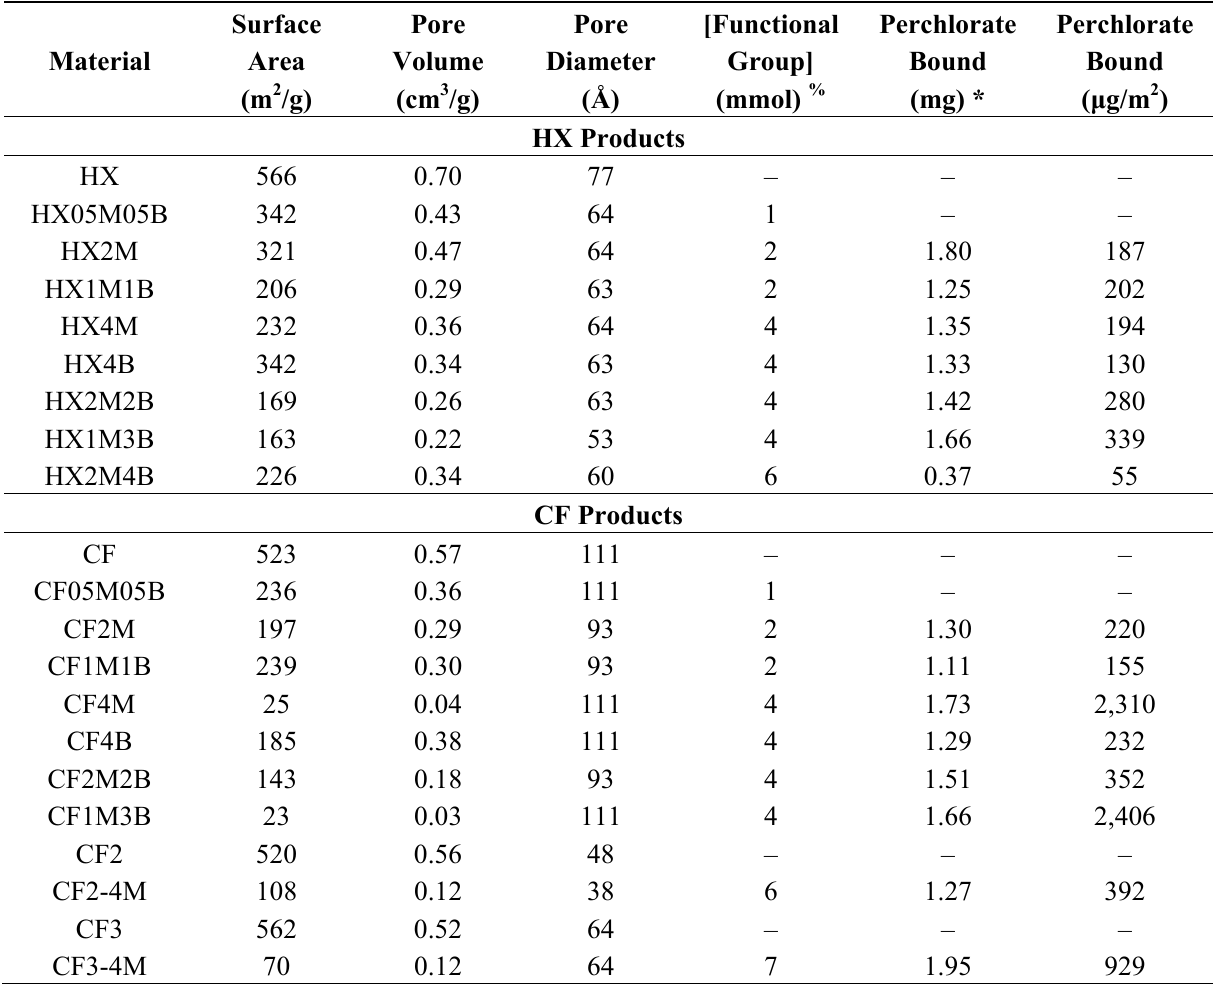
Table 1. Morphological characteristics and target binding for base and alkylammonium functionalized sorbents with a disordered pore arrangement (CF) and with hexagonally packed pores